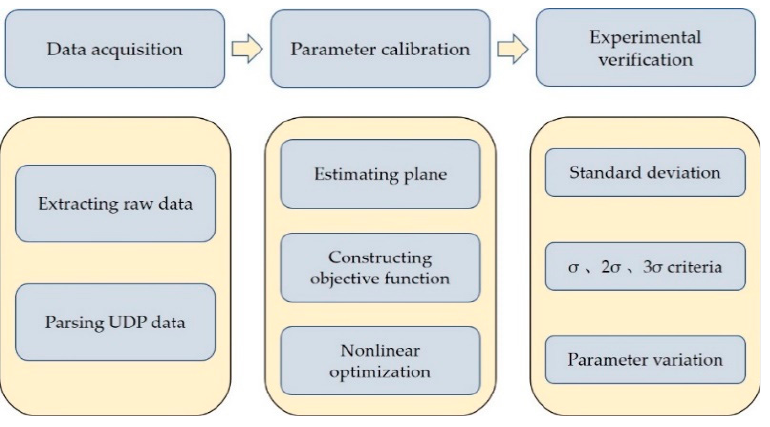
Figure 6. The experimental scheme.